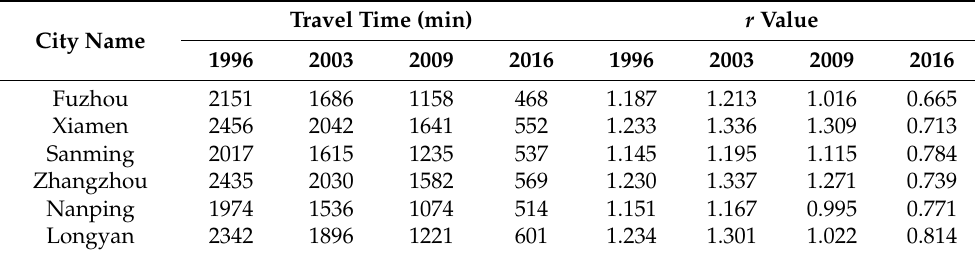
Table 4. Travel times and STCP values for cities in Fujian